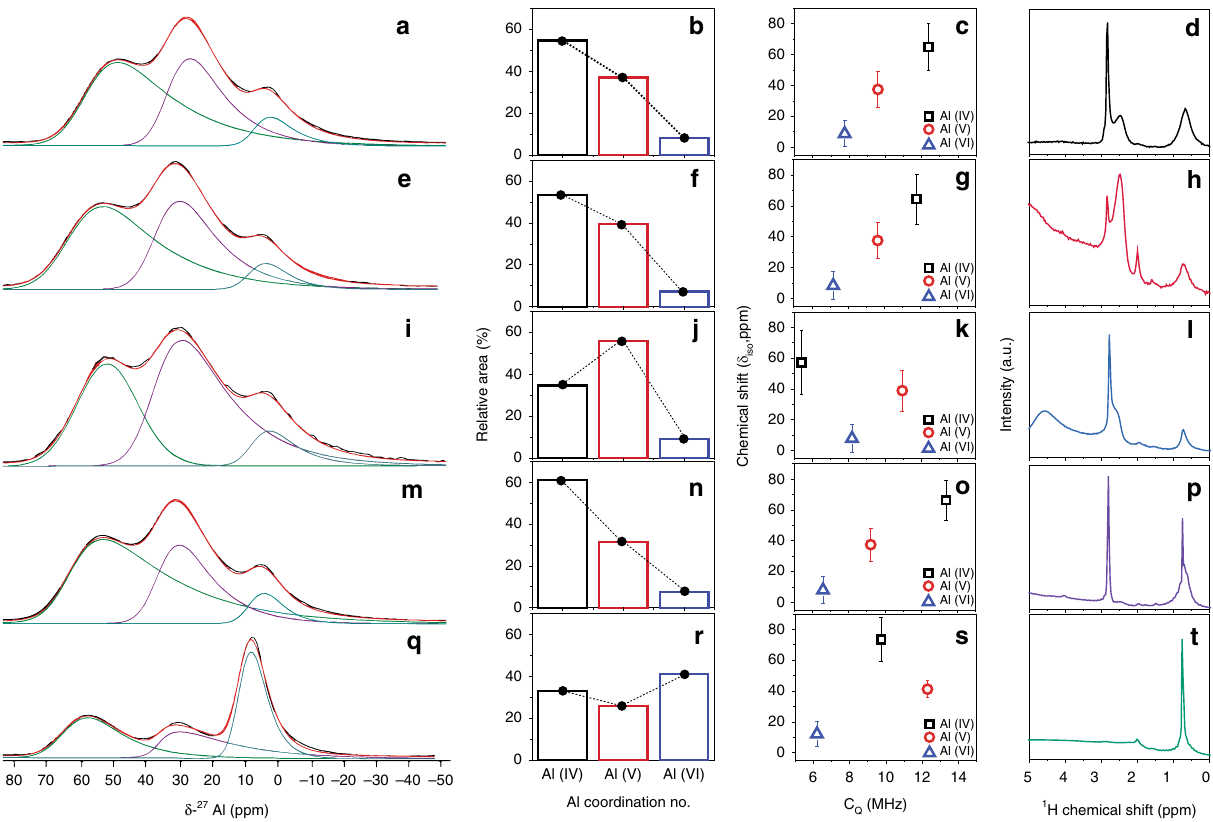
Fig. 6 Characterization of AAS by solid-state NMR. 27 Al direct excitation MAS spectra of AAS samples, a AC*-1.9, e AC-1.9, i AC-9, m AC-1.3, and q IP- 0.3 Decomposition of the spectra was performed using the Gaussian Isotropic Model (Czjzek, d = 5) implemented in the DMFit program. Experimental spectra (black trace), total fi t (red trace), and deconvolutions of individual sites (lower traces) are shown. The peaks were referenced externally to a 1 M aqueous solution of Al(NO 3 ) 3 . Relative peak area of 1D MAS 27 Al spectra ( b , f , j , n , r ), plot of isotropic chemical shift ( δ iso ) against quadrupolar coupling constant ( C Q , MHz) ( c , g , k , o , s ) for the different sites, single-pulse 1 H MAS NMR spectra, ( d , h , l , p , t